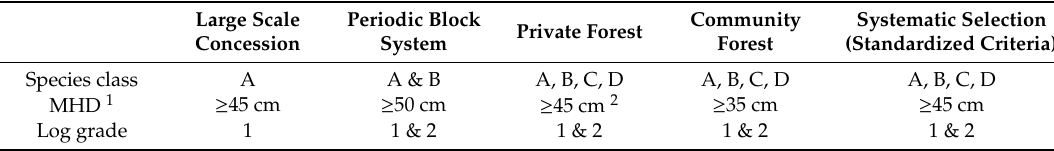
Table 3. Harvest tree selection criteria